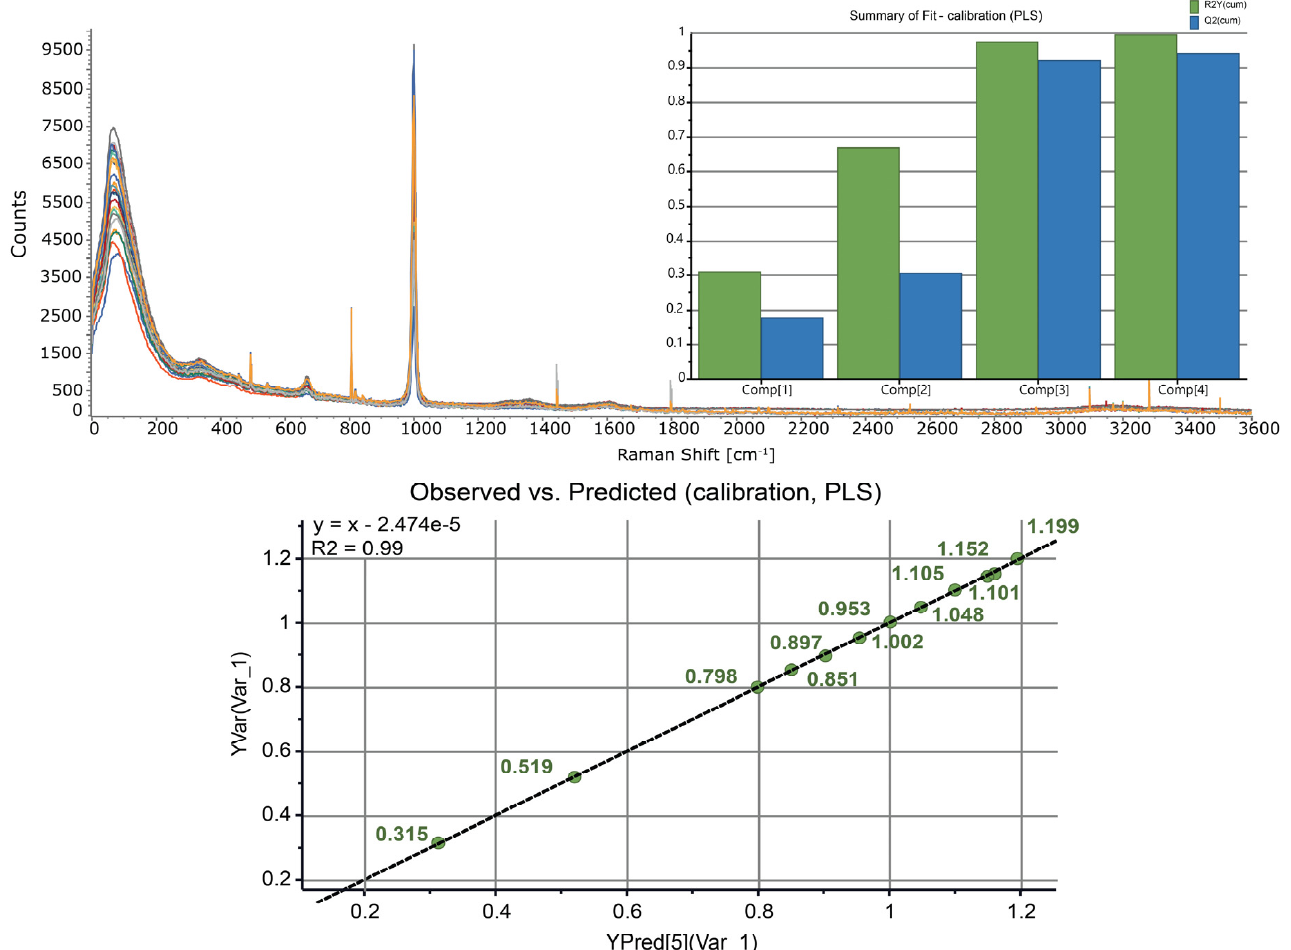
Figure 6. ( Top ) The Raman spectra of Zn(NO 3 ) 2 (0.3 − 1.2 M) prepared in 0.01 M HNO 3 solu- tions. ( Inset ) A four-component PLS calibration model for determination of zinc concentration. ( Bottom ) The performance of the calibration model: observed vs.